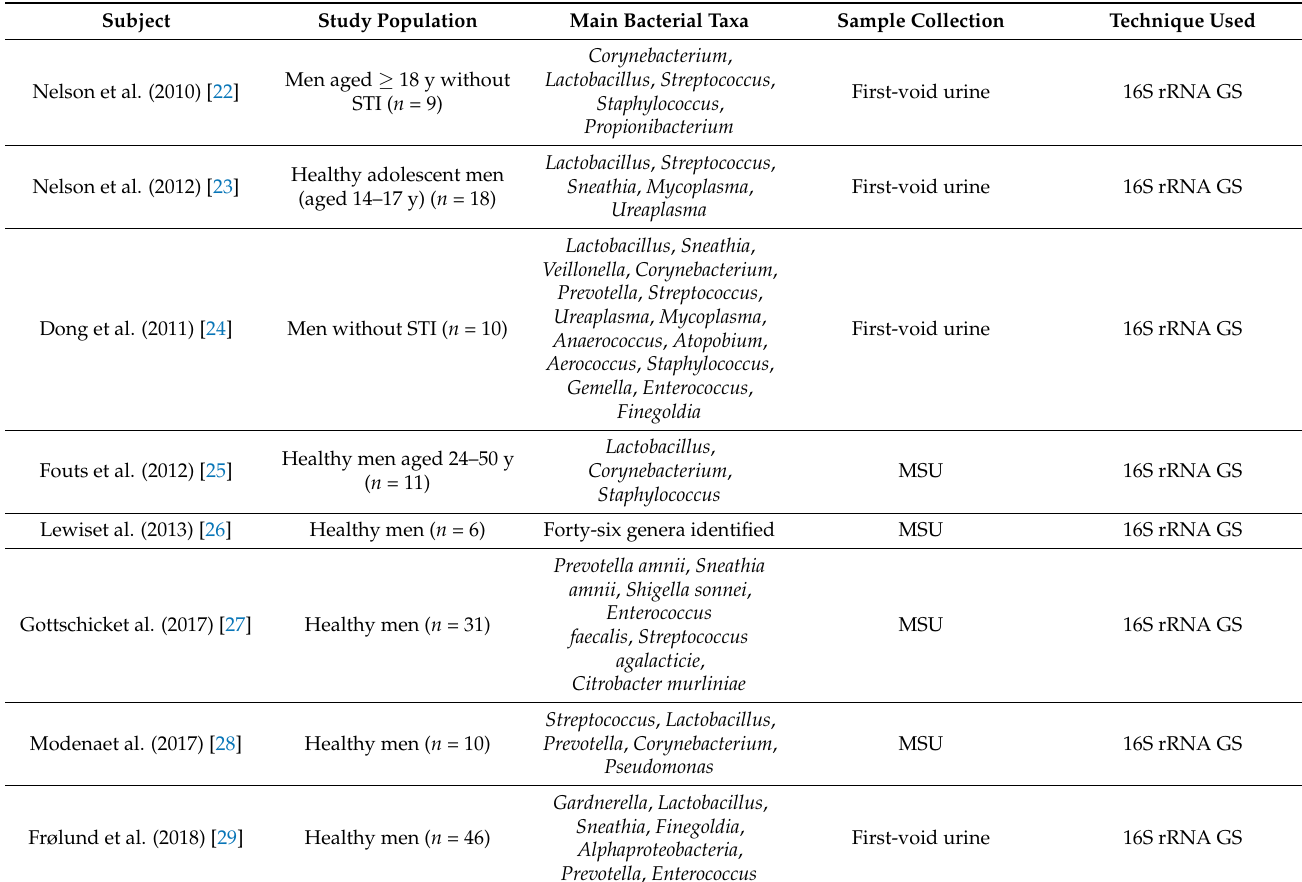
Table 1. Information regarding the urinary microbiota in healthy males